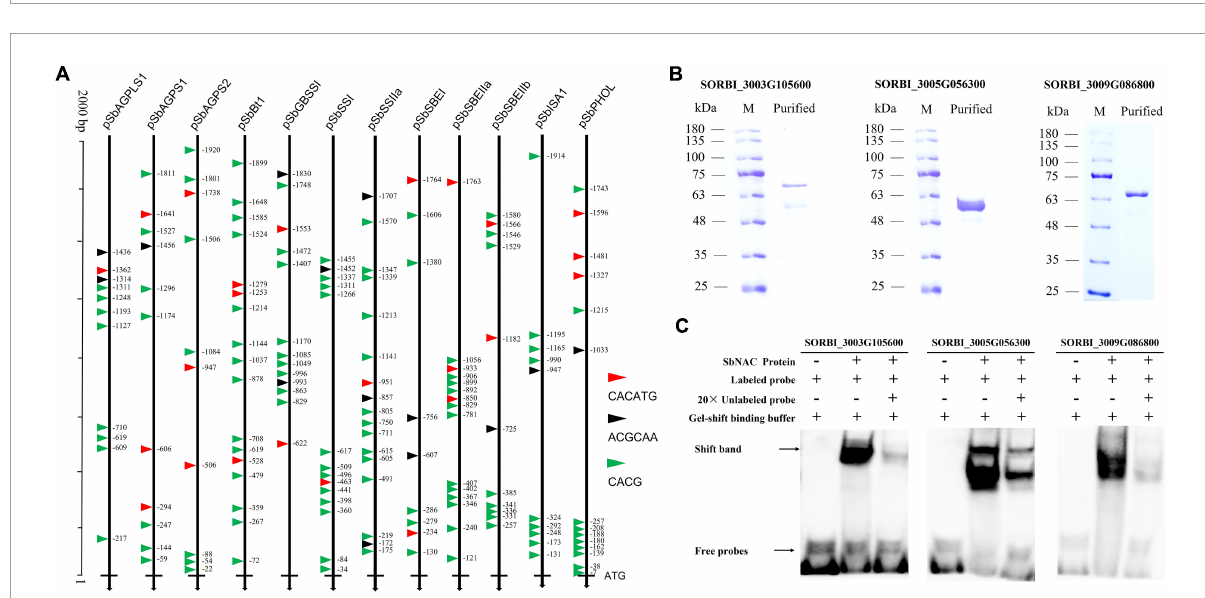
FIGURE6 Binding site detection of NAC TFs and characterization of NAC TFs vs binding motifs. (A) The distribution of CACG core sequence, CACATG, and ACGCAA motif in promoter of sorghum starch biosynthesis-related genes; (B) NAC-type TF proteins obtained from prokaryotic expression system; (C) the binding results of NAC TFs with the ACGCAA motif repeats in vitro . “+” referred to the added composition and “–” to the corresponding component not